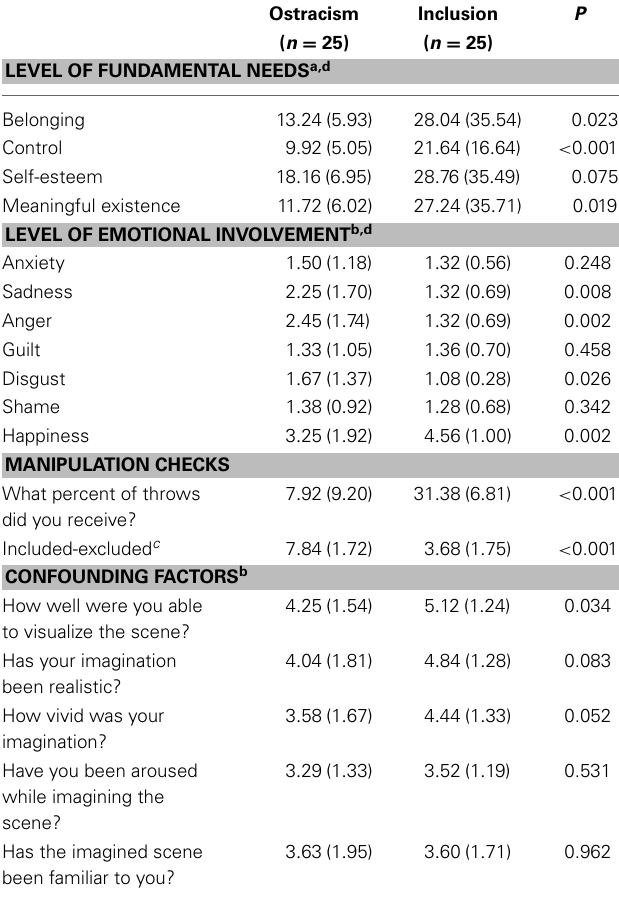
Table 2 | Means and standard deviations (in parentheses) of fundamental needs, levels of emotional involvement, manipulation checks, and confounding